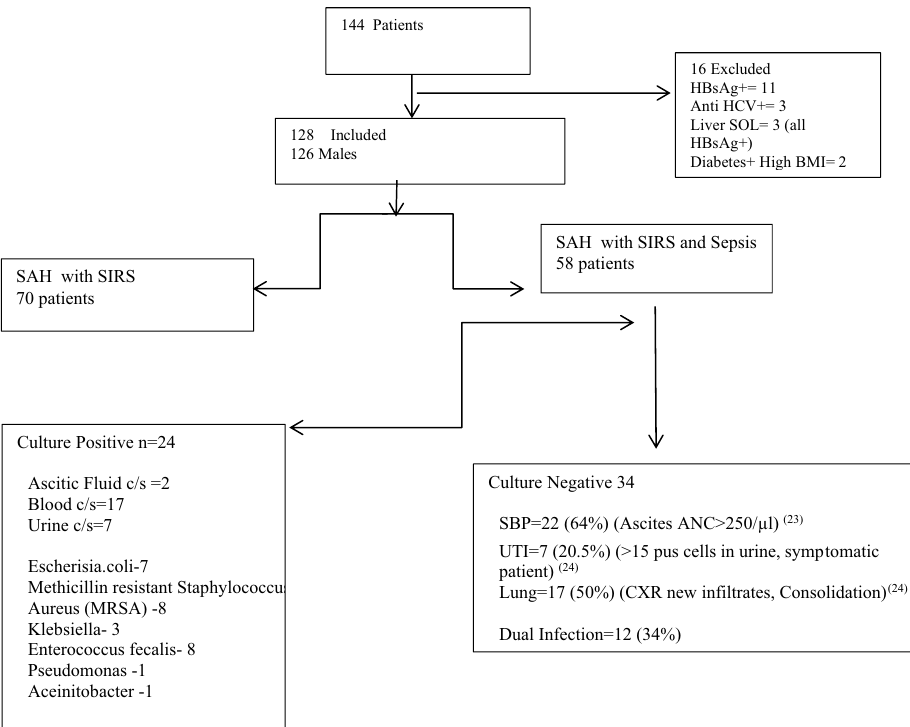
Figure 1. Flow diagram showing enrolment of severe alcoholic hepatitis patients recruited in the study.